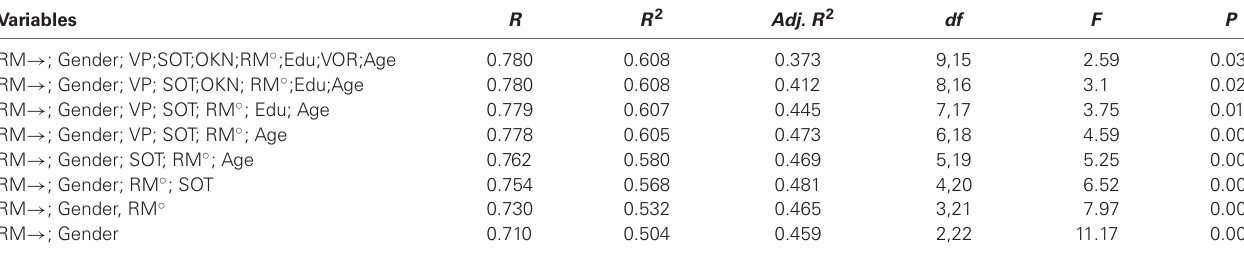
Table 2A | Regression analysis for the Topographical Mental Rotation Test . Variables